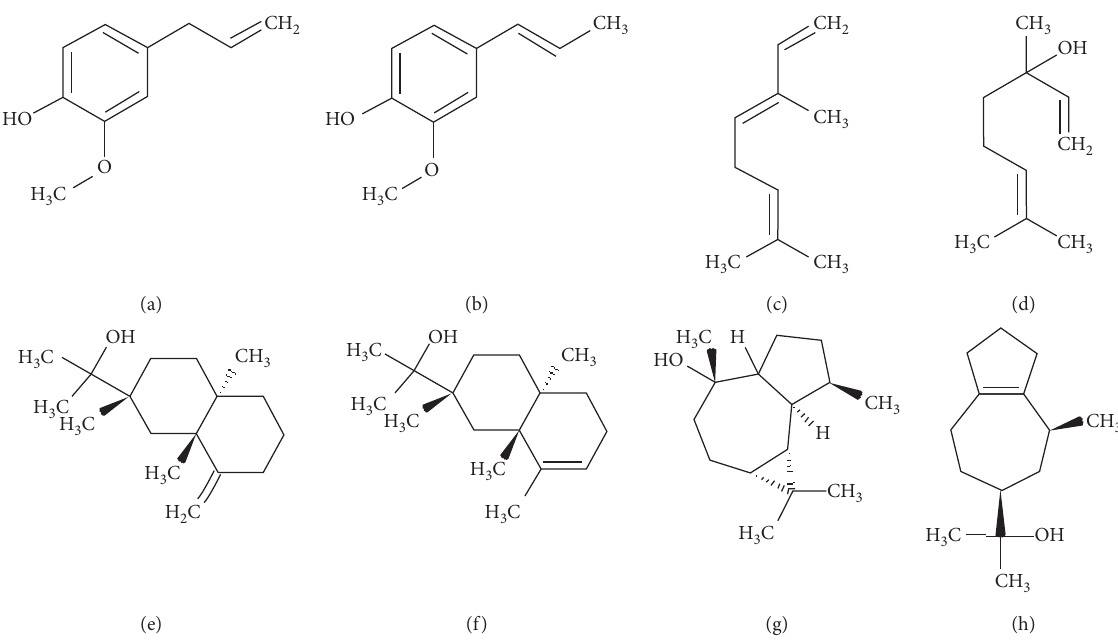
Figure 3: The chemical structure of (a) eugenol, (b) isoeugenol, (c) trans- β -ocimene, (d) linalool (e) β -eudesmol, (f) α -eudesmol, (g) viridiflorol, and (h) guaiol which are benefit for the antibacterial effect and are the components of hydrodistilled essential oil from cajuput leaves.